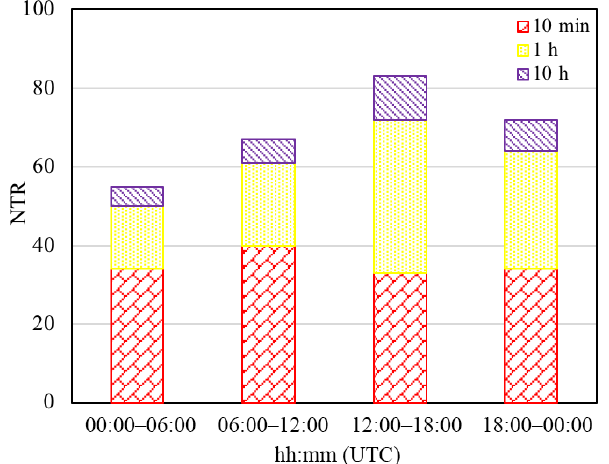
Figure 13. Number of thunderstorm outflow records detected at dif- ferent hours of the